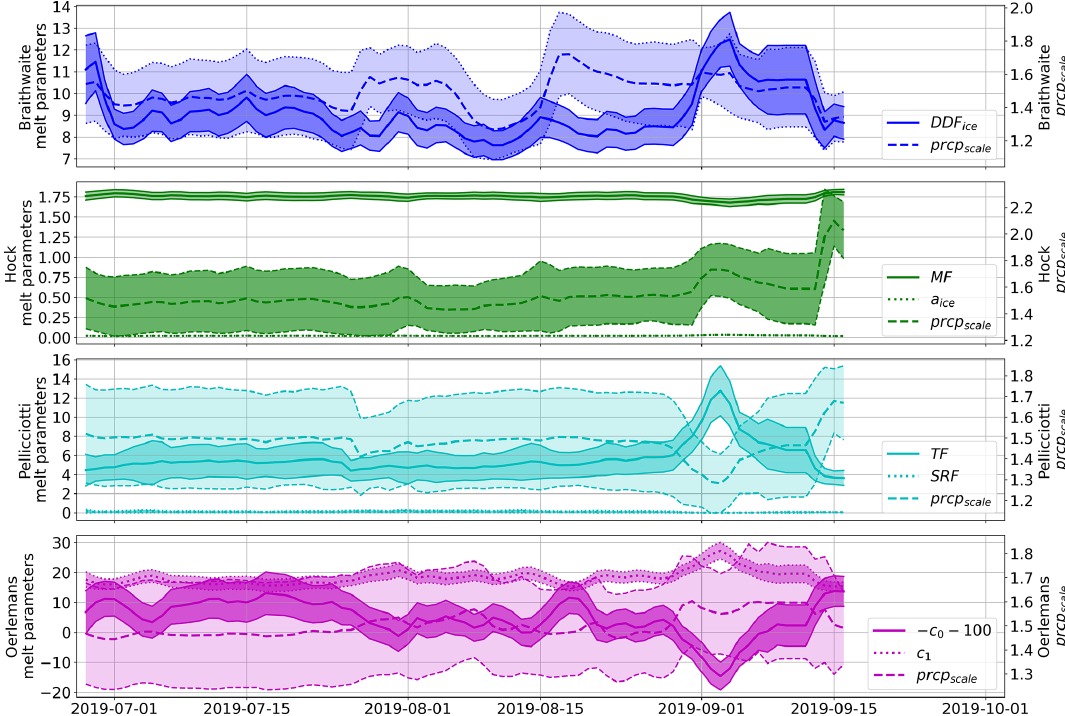
Figure 13. Temporal evolution of the various model parameters for Findelgletscher. Shown are the sample means (lines) and the standard deviations (bands). Note that for the OerlemansModel, parameter c 0 is adjusted to fit on the same scale as c 1